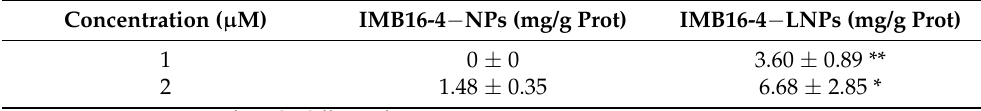
Table 3. Quantitative analysis of cell uptakes. Data are presented as the mean ± SD ( n = 3). Concentration ( µ